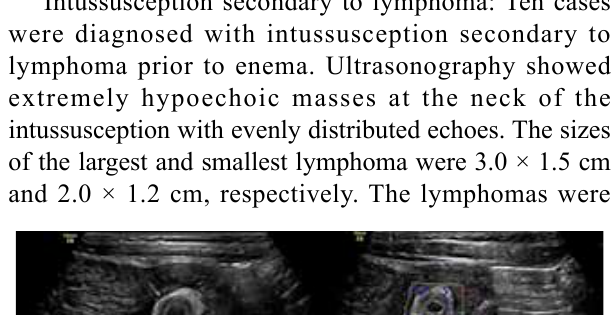
Figure 3 The ultrasonic examination of a boy (age: 3 years, 4 months) showing intussusception secondary to Meckel’s diverticulum which was confirmed by surgery, and the intussusception was found in the right upper abdomen. (A) The long axis showing the “sleeve sign”, the neck of the intussusception showing a Meckel’s diverticulum (arrow) revealed a cystic mass along with a thickened mucous layer and intensified echo in the Ultrasonography; (B) CDFI revealed dot-like blood flow signals at the wall of the cystic mass. Figure 4 The ultrasonic examination of a boy (age: 1 year, 4 months) showing intussusception secondary to Meckel’s diverticulum which was confirmed by surgery. (A) The short axis showing the “target sign”, the tortuous sleeve of the intussusception showing a Meckel’s diverticulum (arrow) with hyperechoic masses; (B) It easier to expose Meckel’s diverticulum(arrow) after water enema.